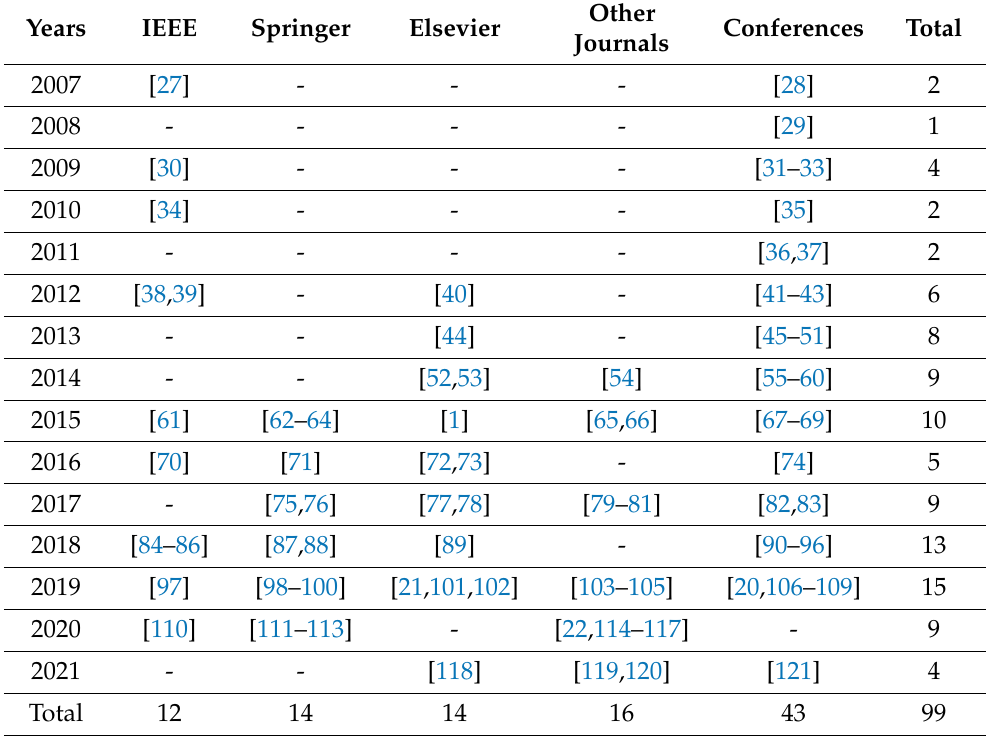
Figure 2. Motion detail of year-wise publications in conferences, journals and others. Table 2. Summary of research papers on passive video forgery detection published in different journals and conference papers.